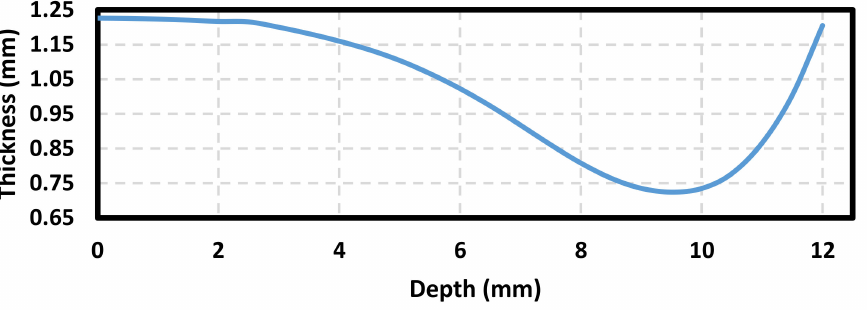
Figure 8. Sample wall thickness variation.